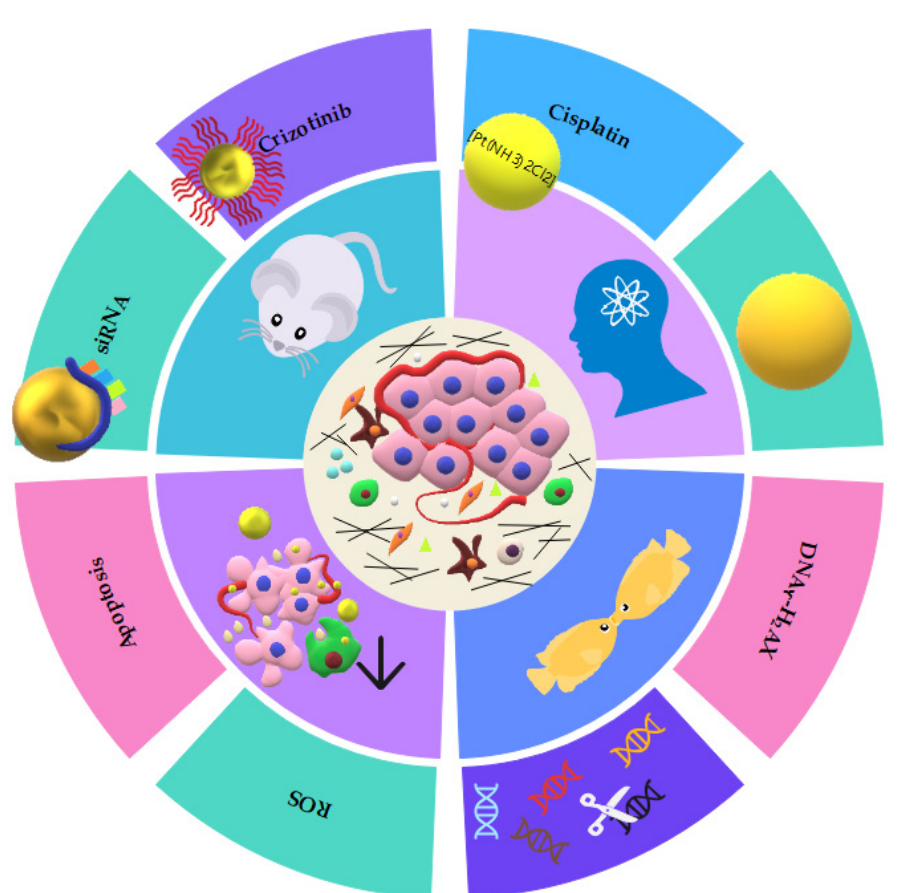
Figure 6. Scheme of in vivo effects of gold nanoparticles. DNA damage, apoptosis, and the elimination of tumor cells are promoted by AuNPs functionalized with chemotherapeutic antibodies or siRNA. siRNA = short interference RNA; ROS = reactive oxygen species.